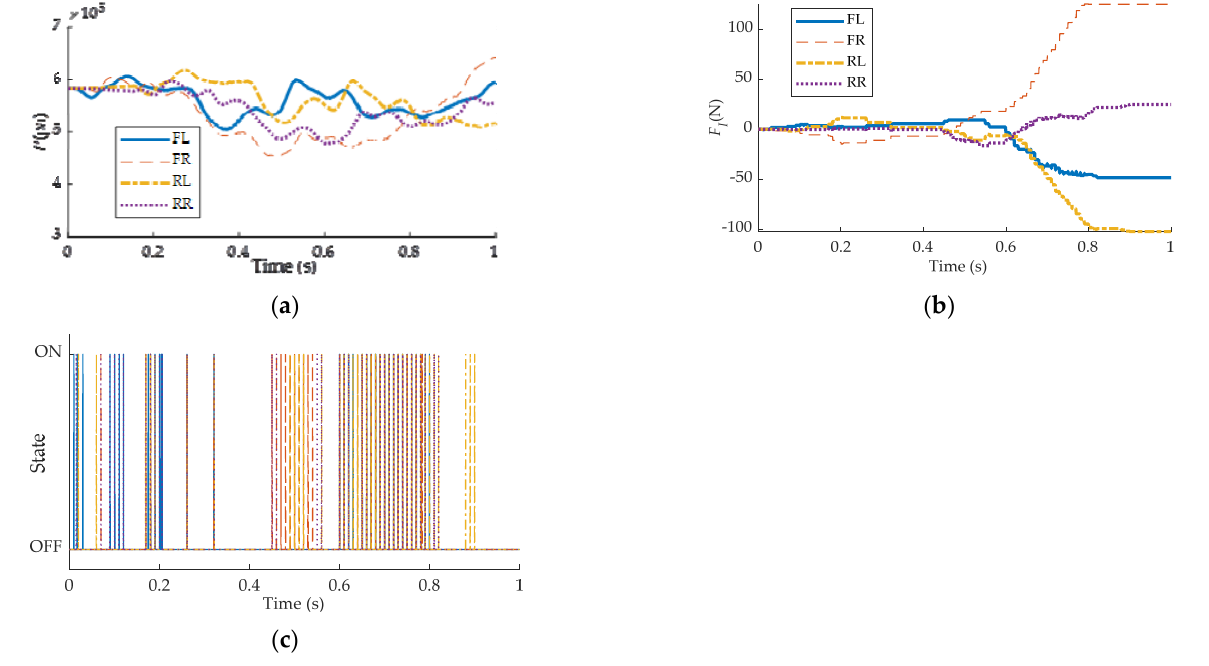
illustrated in Figure 6b and solenoid valve actions in interconnected mode activation are